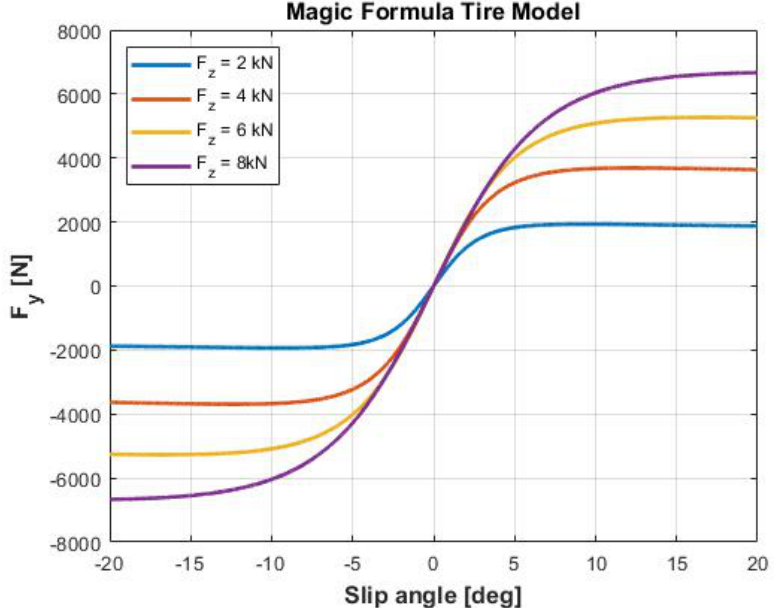
Figure 4. Generic tire lateral side slip angle vs. lateral force for different normal tire force